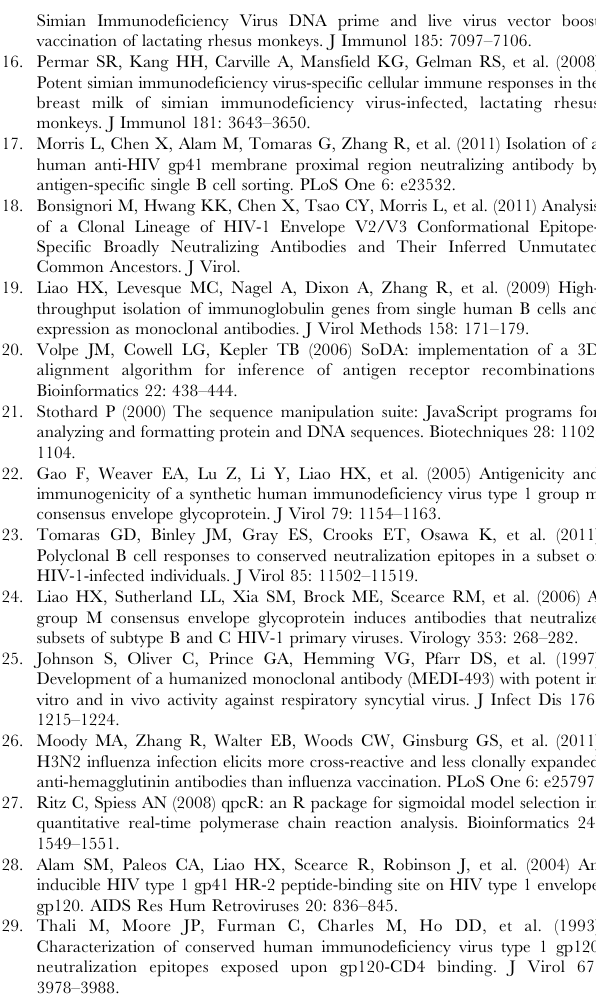
Figure S1 MAb CH08 binding to HIV envelope is blocked by V3-binding CD4i antibodies 17b and 412D. Blocking of biotinylated mAb CH08 binding to ConS gp140 was assessed against CH08 (A), 412-D (B), 17b (C), and 21c (D). X-axis shows the concentration of the blocking antibody added. The Y- axis shows the percent of CH08 that bound in the presence of the blocking antibody compared to the binding of CH08 in the absence of blocking antibody. Error bars are standard error of the mean of results from quadruplicate (CH08, 412-D, and 17b) or duplicate (21c) assays. Figure S2 MAb CH08 contains a sulfation site within the CDR3 region. Western blot of mAbs 412-D (positive control), CH08, and CH07 blotted with an anti-sulfotyrosine mAb. Bands at , 50 kDa in the reduced gel represent at least one positive sulfated tyrosine in the heavy chains of CH08 and 412-D, but not CH07.